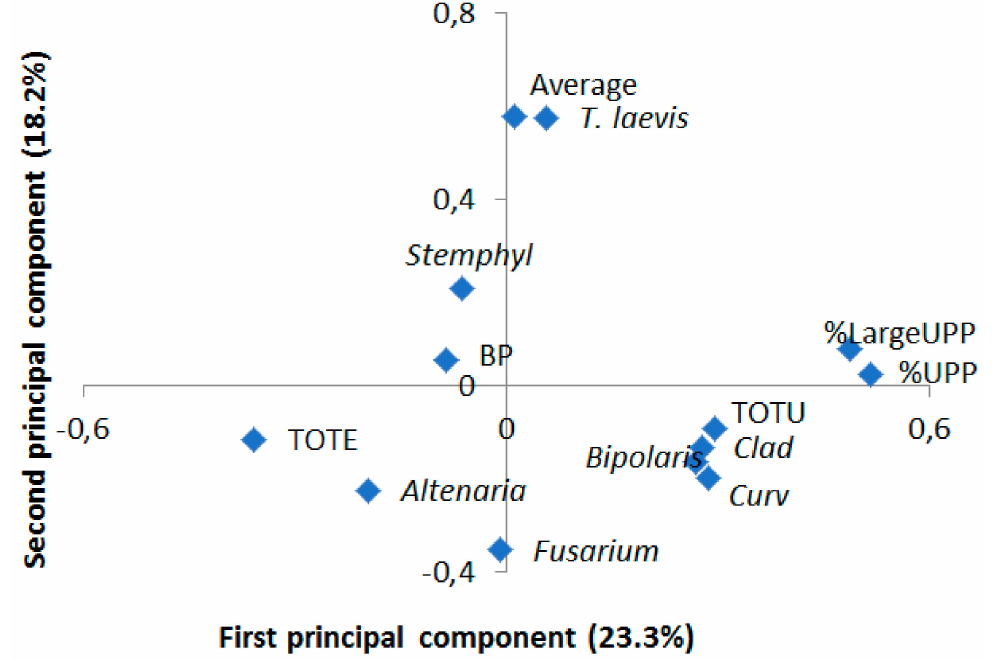
Figure 4. Loading plot from principal component analyses (PCA) of protein composition variables (TOTE = total SDS-extractable proteins; TOTU = total SDS-unextractable proteins; %UPP = percentage of total unextractable polymeric proteins in total polymeric proteins; %LargeUPP = percentage of large unextractable polymeric proteins in total large polymeric proteins) and various seed-borne diseases. The first principal component explained 23.3% of the variation, while the second principal component explained 18.2% of the